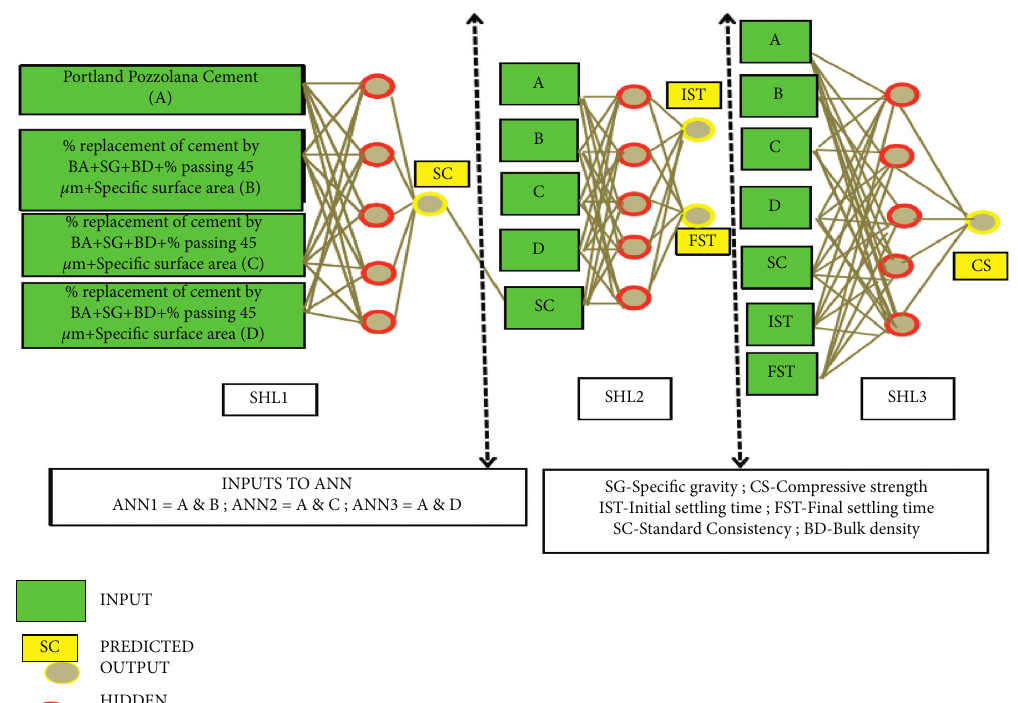
Figure 2: Proposed FCC ANN model (A ⟶ PPC; B ⟶ BA+SG +BD+percentage passing 45 µ m +specific surface area; C ⟶ RHA+ SG+BD +percentage passing 45 µ m+specific surface area; D ⟶ BA +RHA+SG+BD +percentage passing 45 µ m+specific surface area. For ANN1, inputs are both A and B; for ANN2, A and C; for ANN3, A and